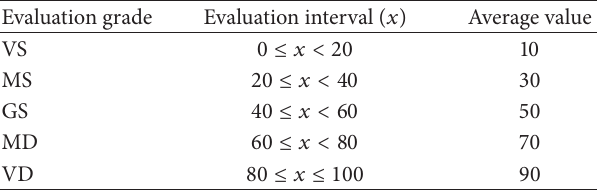
Table 2: The BPA.